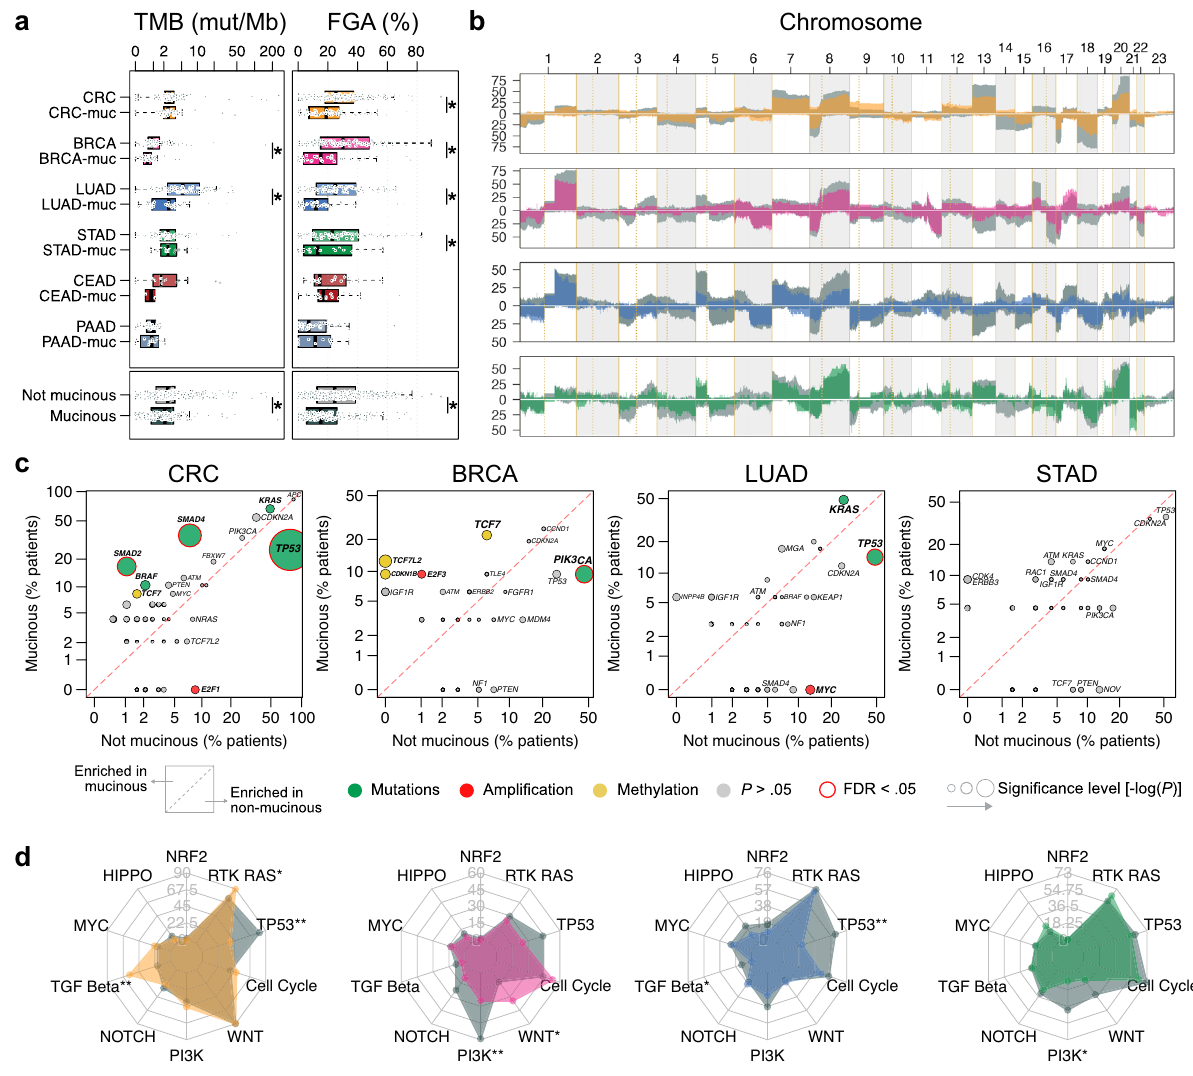
Figure 2. The unique genomic landscape of carcinomas with mucinous differentiation from different cancer types. ( a ) Comparison of TMB (left), FGA (middle) and the number of driver alterations (right) between carcinoma-muc and control for each cancer type (*; FDR < 0.05). Statistical significance was measured using the pairwise Mann–Whitney U tests adjusted for multiple comparisons. ( b ) Comparison of the CNAs frequencies between carcinoma-muc (colored) and control (grey) for each cancer type. ( c ) Comparison of the frequency of recurrent oncogenic alteration present in each cancer type. Statistical significance was measured using the Fisher’s exact test adjusted for multiple comparisons. ( d ) Percentages of patients with alterations in canonical oncogenic signaling pathways between carcinoma-muc (colored) and control (grey) for each cancer type (*P < 0.05, **FDR < 0.05). Note that the NRF2 pathway was not altered in PAAD. Statistical significance was measured using the Fisher’s exact test adjusted for multiple comparisons. TMB tumor mutation burden, FGA fraction of genome altered, CRC colorectal adenocarcinoma, CRC-muc colorectal mucinous adenocarcinoma, BRCA infiltrating ductal carcinoma breast cancer, BRCA-muc mucinous carcinomas of the breast, LUAD lung adenocarcinoma, LUAD-muc mucinous (colloid) adenocarcinoma of the lung, STAD stomach adenocarcinoma, STAD-muc mucinous adenocarcinoma of the stomach, CEAD endocervical adenocarcinoma, CEAD-muc mucinous adenocarcinoma of endocervical type, PAAD pancreas-adenocarcinoma ductal type, PAAD-muc pancreas-colloid (mucinous non-cystic)